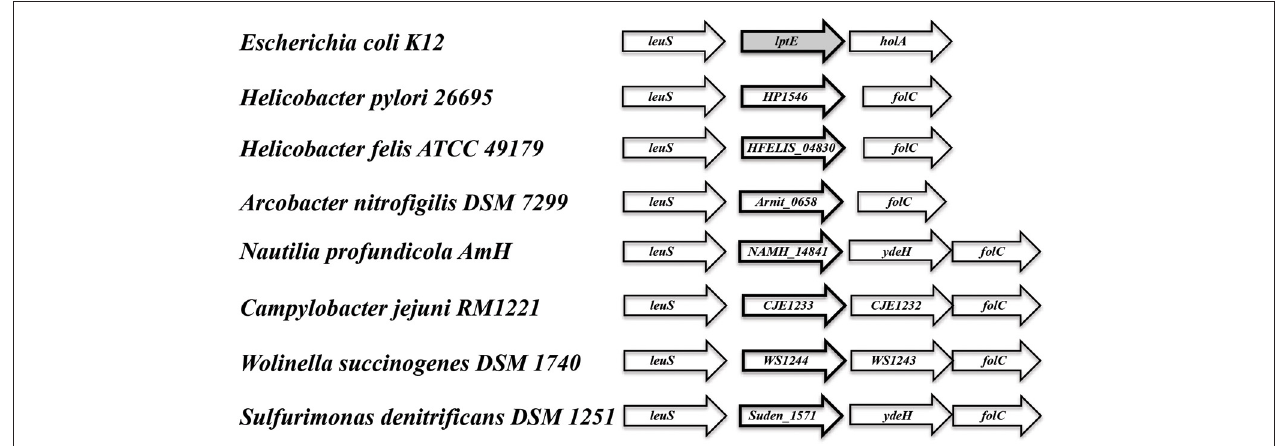
FIGURE 5 | Genes encoding putative lipoproteins of unknown function are found adjacent to leuS (leucyl-tRNA synthetase) in ε proteobacteria. While having limited sequence similarity to lptE , the conserved orientation of the lipoprotein encoding genes downstream of leuS , in addition a high similarity score at the putative protein structural level to LptE from